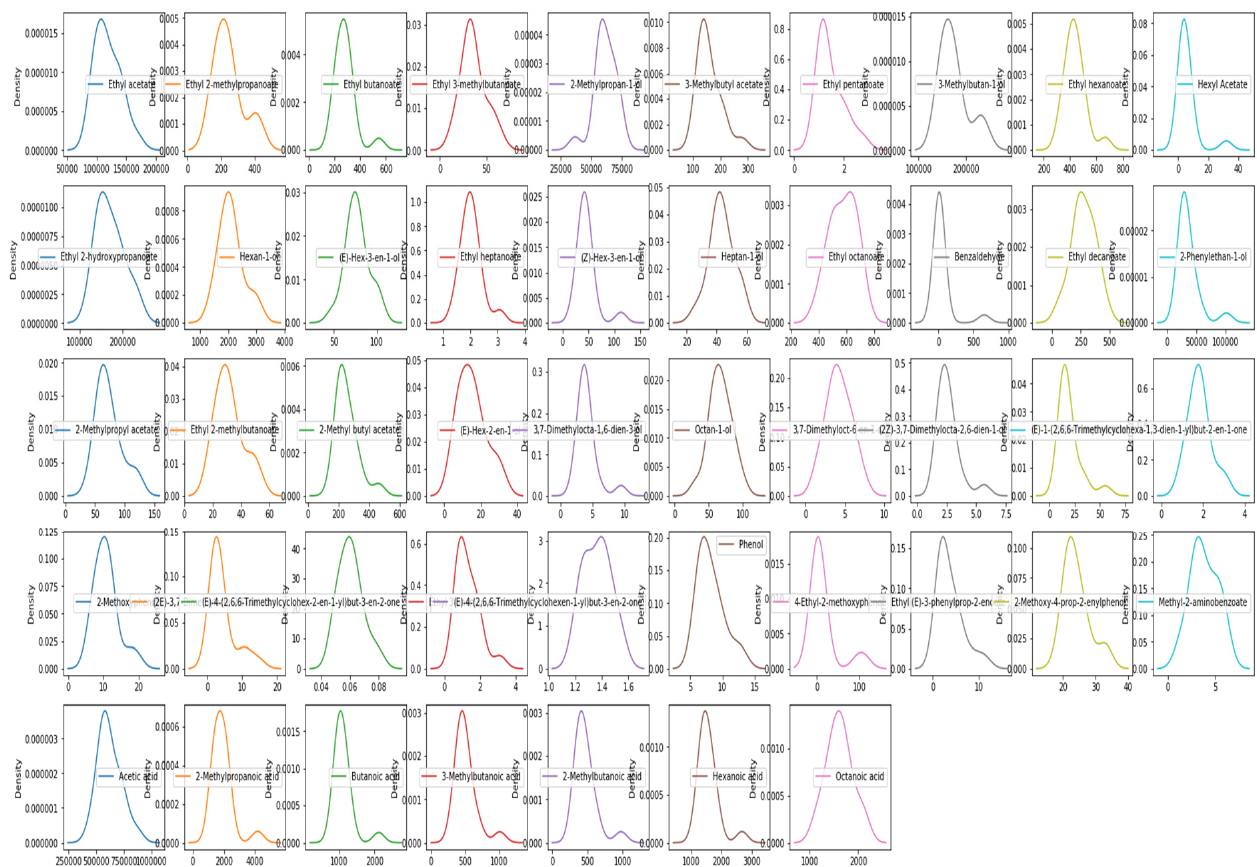
Figure 3. Density plot of each chemical compound present in the New Zealand’s Pinot noir wine dataset1.